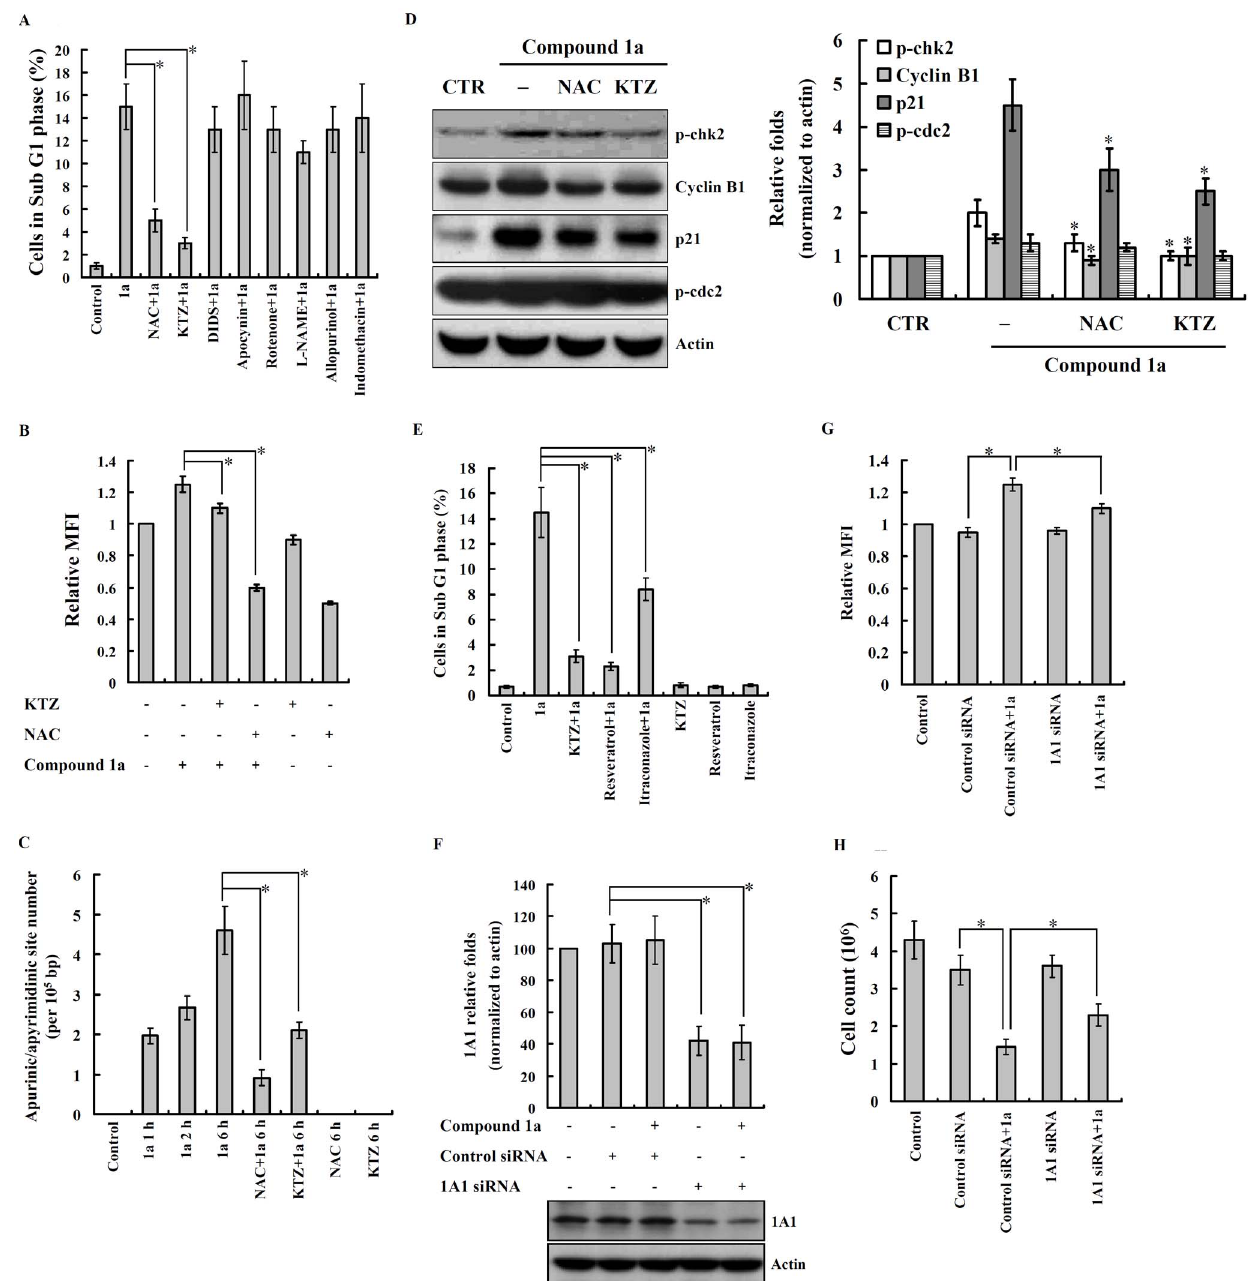
Figure 5. Compound 1a-induced apoptosis and DNA damage through cytochrome P450. ( A ) OEC-M1 cells were incubated with NAC (10 mM), ketoconazole (KTZ, 50 mm M), diisothiocyanatostilbene-disulfonic acid (DIDS, 10 m M), apocynin (0.3 m M), rotenone (1 m M), L-NAME (500 m M), allopurinol (100 m M), indomethacin (50 m M) for 30 min, followed by compound 1a (5 m M) or vehicle (0.1% DMSO) treatment for 24 h. The cell cycle distribution was determined by flow cytometry after PI-staining of nuclei. ( B ) OEC-M1 cells were incubated with KTZ (50 m M) and NAC (10 mM) in the presence of 2 9 ,7 9 -dichlorofluorescein diacetate (2 m M) for 30 min, followed by compound 1a (5 m M) or vehicle (0.1% DMSO) treatment for 30 min, and then the ROS production was measured. ( C ) OEC-M1 cells were incubated with NAC (10 mM) or ketoconazole (KTZ, 50 m M) for 30 min, followed by compound 1a (5 m M) or vehicle treatment for the time as indicated. AP sites of DNA lesions were analyzed by a DNA damage quantification kit. ( D ) OEC-M1 cells were treated with NAC (10 mM) or ketoconazole (KTZ, 50 m M) for 30 min, followed by compound 1a (5 m M) or vehicle (0.1% DMSO) treatment for 2 or 16 h. The expression levels of p-chk2 (2 h), cyclin B1, p21, and p-cdc2 were measured by western blotting. ( E ) OEC-M1 cells were incubated with resveratrol (100 m M) or itraconazole (10 m M) for 30 min, followed by compound 1a (5 m M) or vehicle treatment for 24 h. The cell cycle distribution was determined by flow cytometry after PI-staining of nuclei. ( F ) Untreated OEC-M1 cells, cytochrome P450 1A1 siRNA transfected OEC- M1 cells, and control siRNA transfected OEC-M1 cells were incubated with compound 1a (5 m M) or vehicle for 24 h and then the cytochrome P450 1A1 expression were measured by western blotting. ( G ) Untreated OEC-M1 cells, cytochrome P450 1A1 siRNA transfected OEC-M1 cells, and control siRNA transfected OEC-M1 cells were incubated with compound 1a (5 m M) or vehicle for 30 min and then the ROS production was measured. ( H ) Untreated OEC-M1 cells, cytochrome P450 1A1 siRNA transfected OEC-M1 cells, and control siRNA transfected OEC-M1 cells were incubated with compound 1a (5 m M) or vehicle for 24 h. The cell number was determined by trypan blue staining. In ( A ), ( B ), ( C ), ( E ), ( G ) and ( H ), the data are